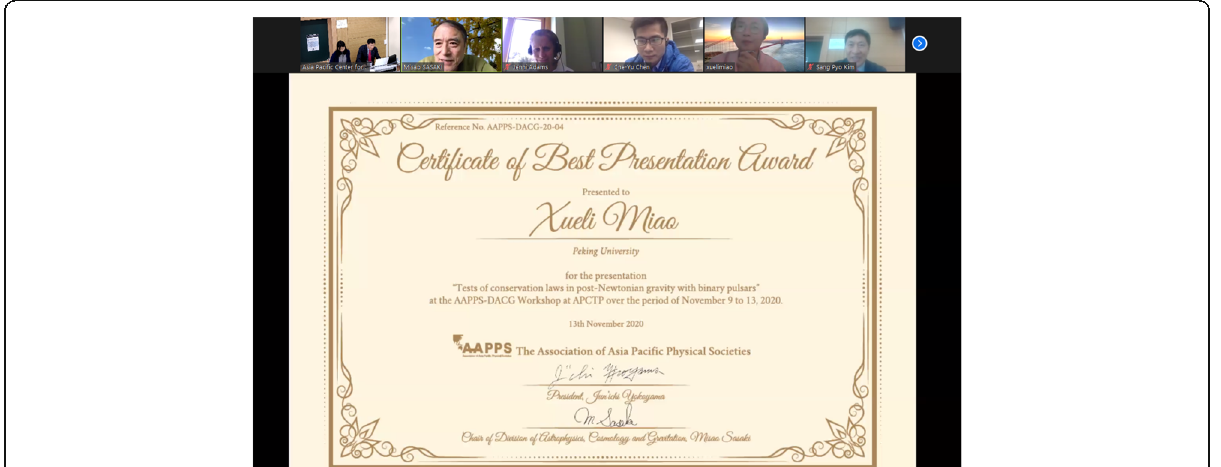
Fig. 4 The Certificate of the Best Presentation Award for Xueli Miao, a graduate